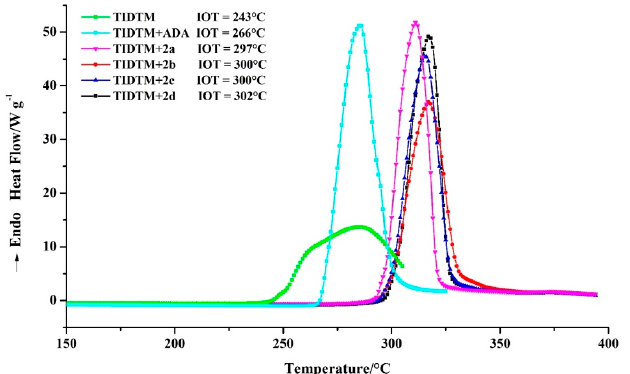
Figure 4. The incipient oxidation temperatures of TIDTM and TIDTM containing 1 wt % ADA and compounds 2a – d , respectively.